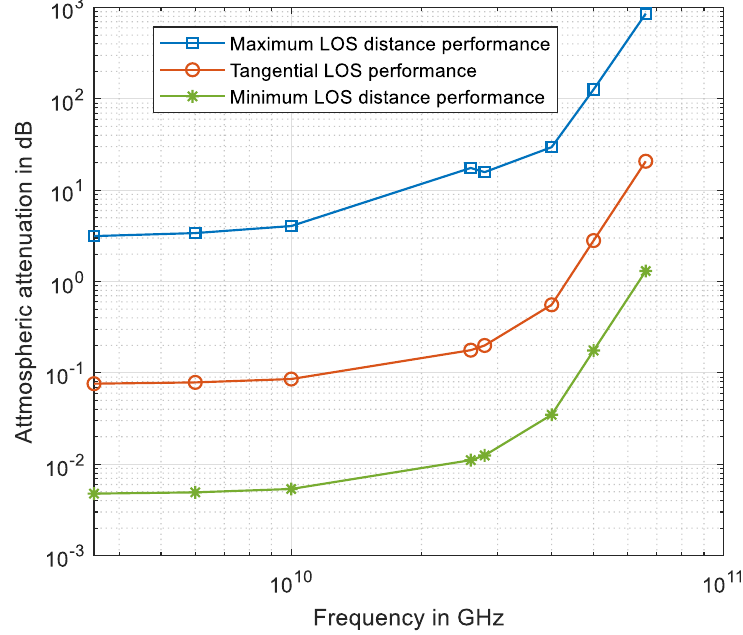
Figure 15. Atmospheric gaseous attenuation for three different handover scenarios.